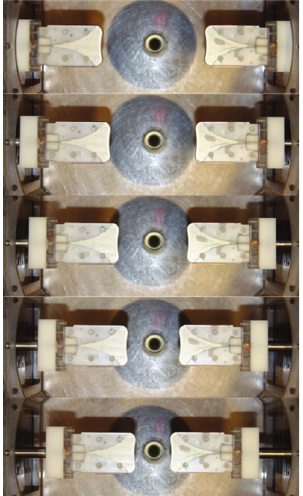
Figure 4: View of the sensors set at di ff erent separation